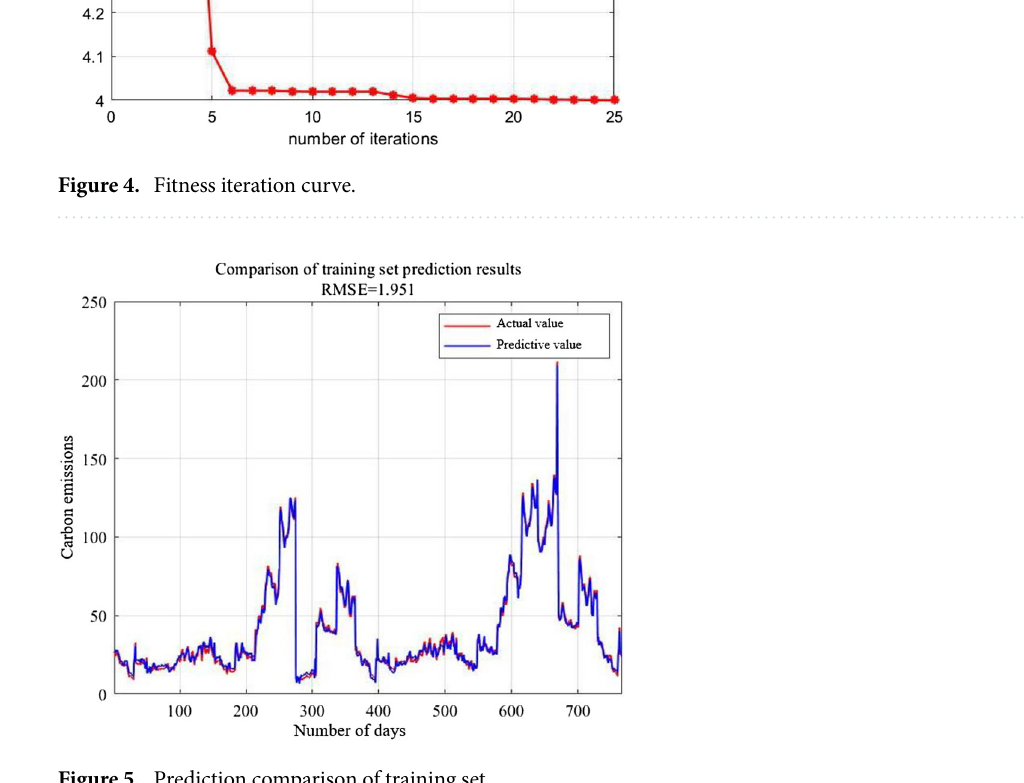
Figure 5. Prediction comparison of training